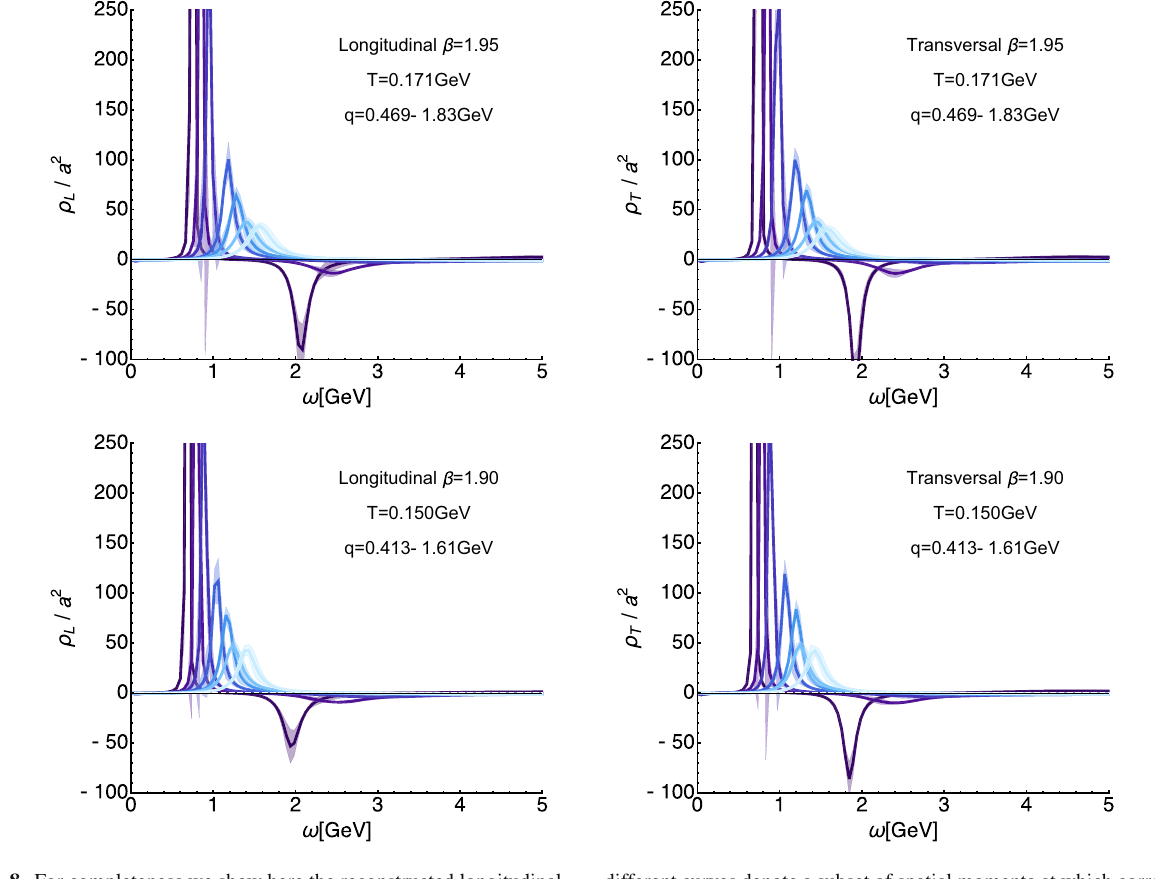
different curves denote a subset of spatial momenta at which correlator data is available, lighter colors denote larger